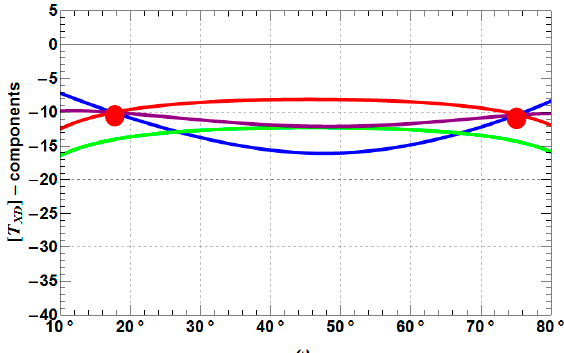
Figure 5. Sensitivity of coherency matrix elements T XD11 (blue), T XD12 (purple), T XD22 (red) and T XD33 (green) (dB) with local incidence angle ω l ( ε s = 20, ε t = 10, θ 1 = 30°, L SXD = 1, ϕ = 0°). Red points indicate the Brewster angle locations.